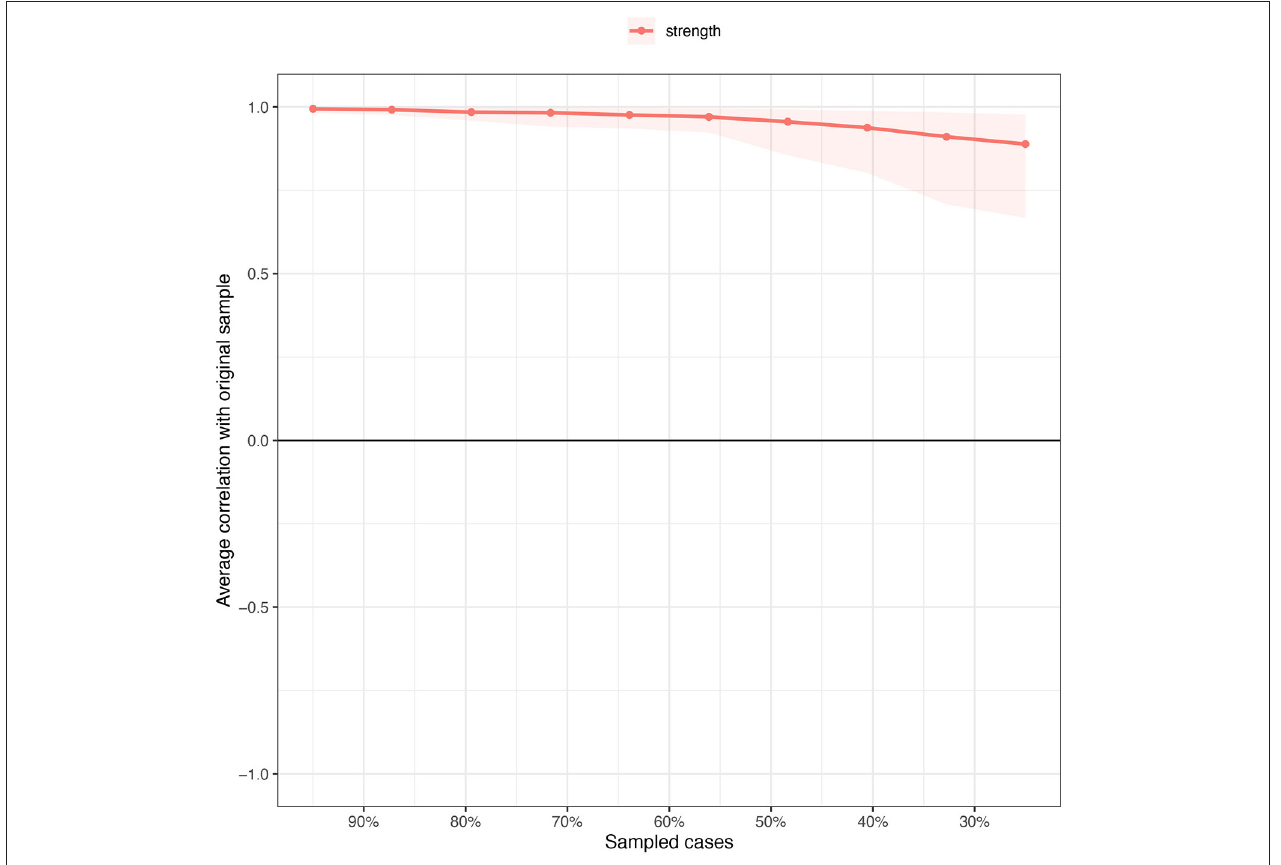
FIGURE 3 | Stability of strength centrality (the average correlation with original sample) estimated by case dropping subset bootstrapped